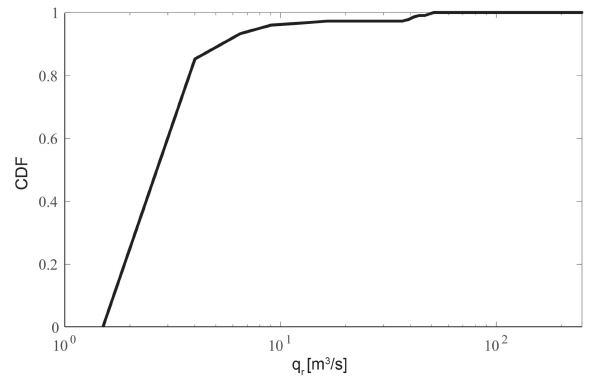
Figure 11. Cumulative distribution function (CDF) of the highest fifth percentile of the daily values of q r at the outlet (sub10).